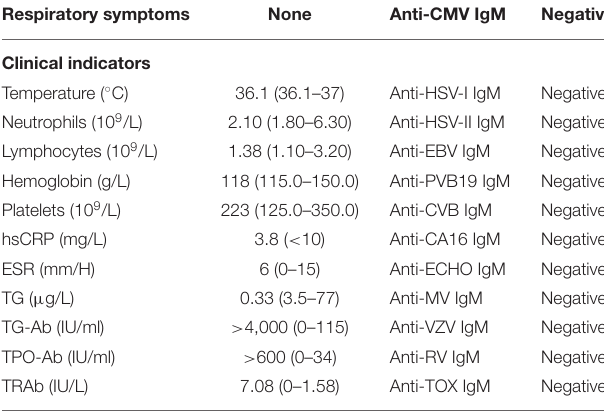
TABLE 2 | Clinical indicators about